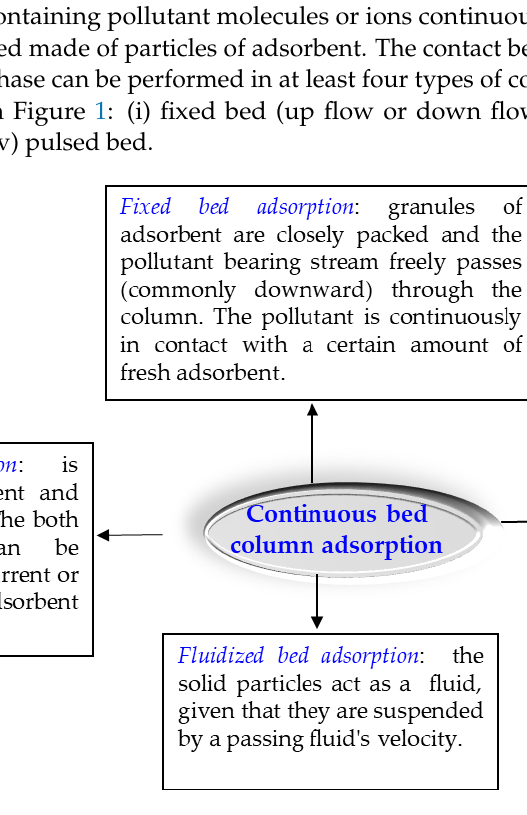
Figure 1. Main types of column adsorption procedures [9,112–114].